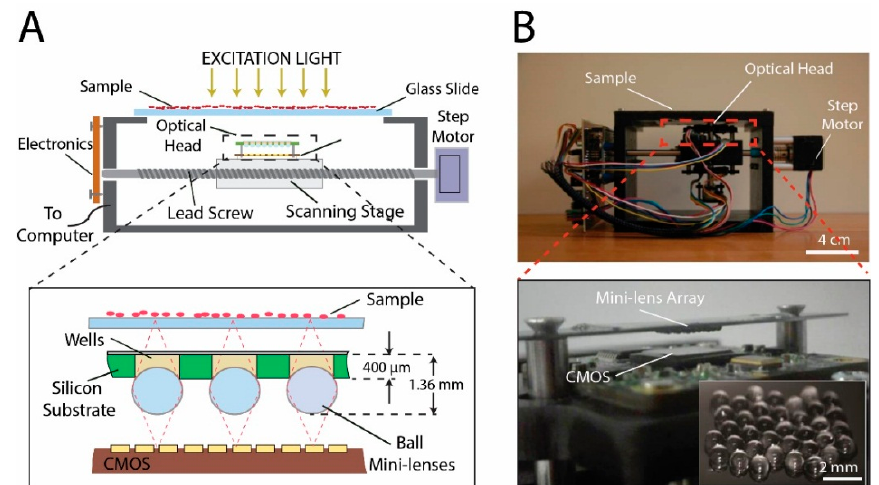
Figure 1. ( A ) Schematic of the architecture of the integrated, portable scanning system and cross sectional view of the optical head; ( B ) photograph of the prototype and close-up view of the optical head.